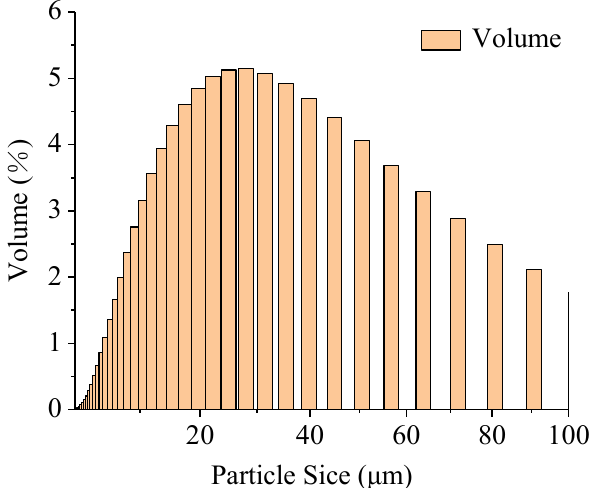
Figure 4. Particle size distribution of the cement. Table 2. Major chemical constituents of